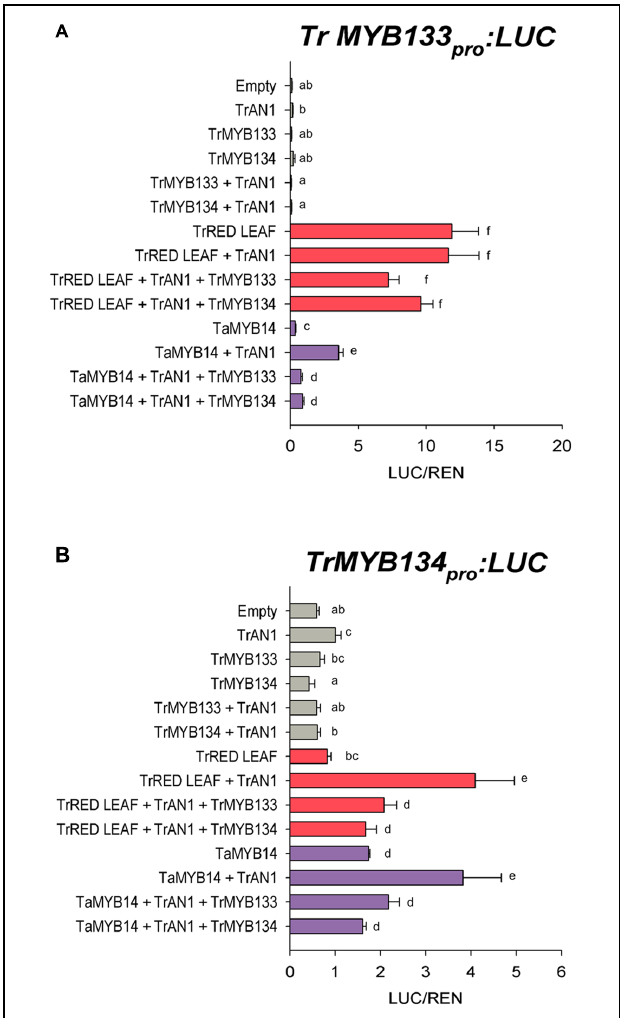
FIGURE 4 | Tr-MYB133 and Tr-MYB134 are regulated by different MBW complexes. Promoter activation/repression dual luciferase assays upon (A) the Tr-MYB133 promoter or (B) the Tr-MYB134 promoter, using Agrobacteria -infiltrated N. benthamiana leaves. Combinations of activator R2R3-MYB genes Tr-RED LEAF (anthocyanin) or Ta-MYB14 (proanthocyanidin) were tested with or without the bHLH factor Tr-AN1, and the R2R3-MYB repressors Tr-MYB133 or Tr-MYB134. Firefly luciferase activity was normalized to Renilla luciferase activity (LUC/REN); mean ± SEM n = 5 biological replicates are shown. Means that are significantly different are indicated by different letters, as determined by post hoc Fisher’s LSD (5%).